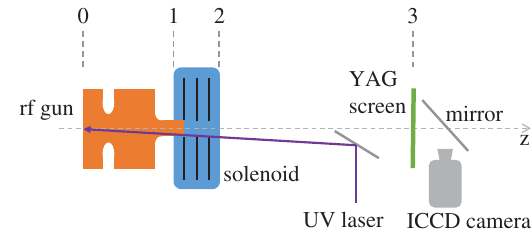
FIG. 1. Thermal emittance measurement setup at